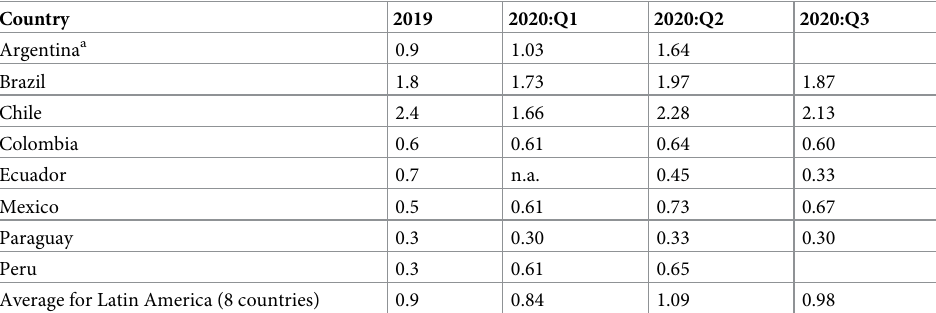
Table 2. Ratio of persons employed in the formal sector relative to the informal sector, selected Latin American countries, 2020. Country